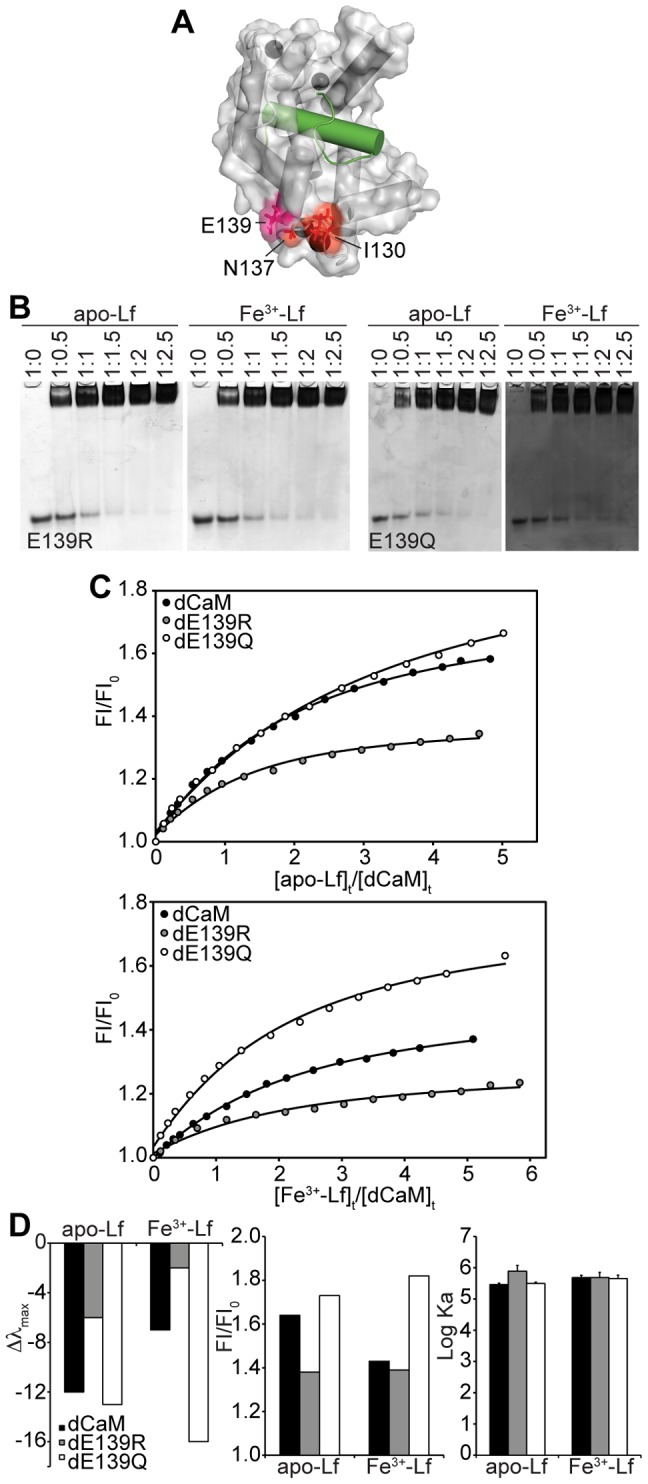
Disrupting the Secondary Interface.
A) Residues that make up a secondary interface (red) as identified from CSP and cross-saturation data are indicated on the structure of Ca2+-CaM (grey, surface representation) bound to the CaMKK peptide (green, helix). The position of the mutant studied, Glu-139 is indicated (deep pink). B) Non-denaturing PAGE band shift analysis of the interaction of CaM mutants E139R and E139Q with apo/Fe3+-Lf. The ratio of CaM to Lf is indicated above each lane. C) Steady-state fluorescence titration of wild-type and mutant dCaMs with apo- or Fe3+-Lf. The relative fluorescence intensities are plotted against the ratio of total Lf and dCaM concentrations. D) Fluorescence parameters and derived binding constants for apo- or Fe3+-Lf binding to wild-type and mutant dCaMs in 100 mM KCl. Error bars represent SEM for three independent titrations.